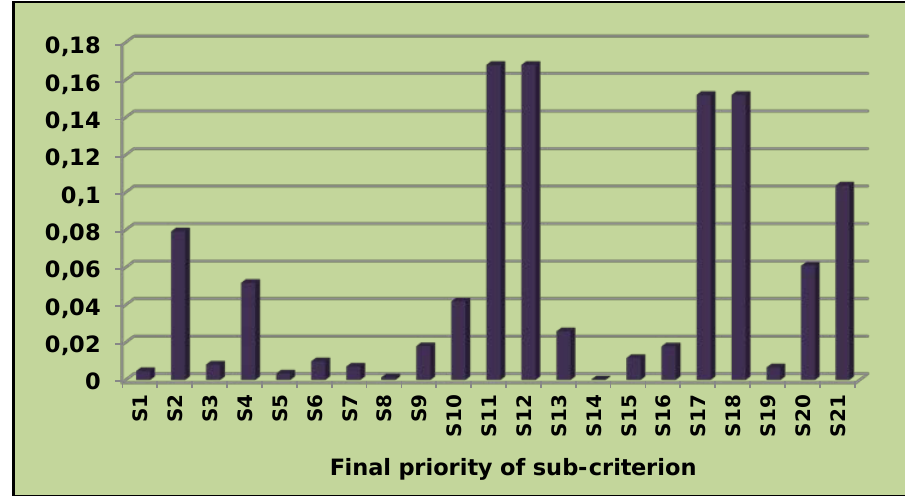
Figure 5. “Importance of sub-criterion for the evaluation of